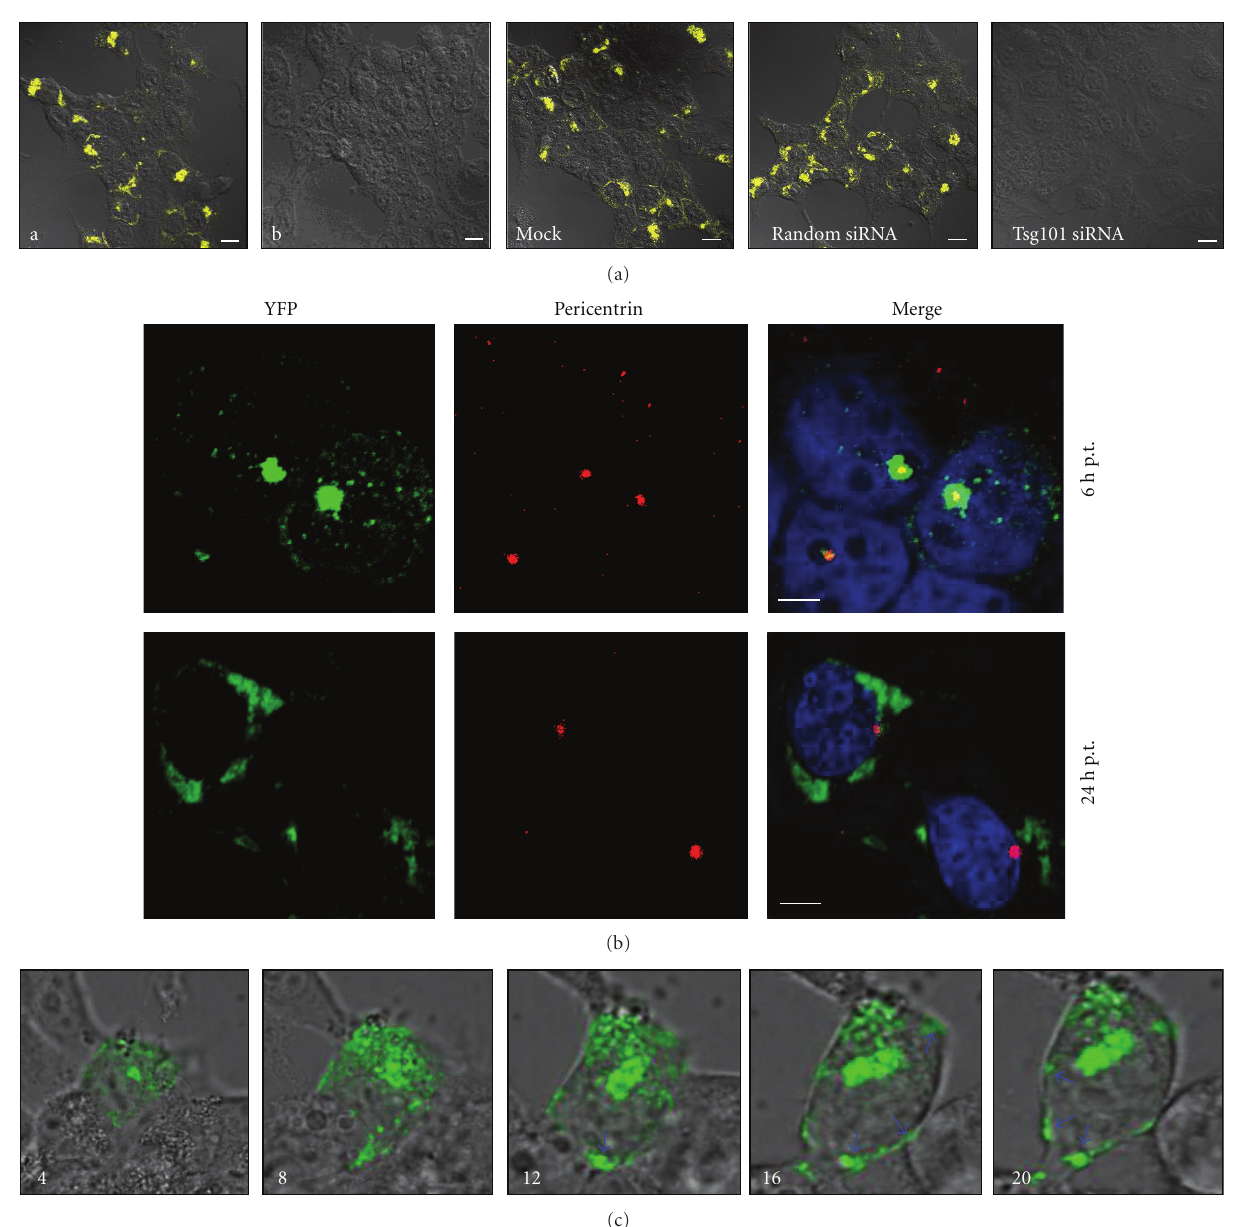
Figure 2: BiMC detecting eVP40-Tsg101 interactions and tra ffi cking of Tsg101/eVP40 complex. (a) Human 293T cells grown on coverslips in 6-well plates were transfected with NYFP-Tsg101 + CYFP-eVP40-WT (a) or NYFP-Tsg101 + CYFP-eVP40- Δ PT/PY. (b) Cells were washed, fixed, and examined for YFP fluorescence by confocal microscopy at 24 hours p.t. Cells were mock-transfected, or transfected with 20nM of Tsg101-specific or random siRNA. Twenty four hours later, cells were mock-transfected or transfected with the same amount of siRNA along with NYFP-Tsg101 + CYFP-eVP40. After an additional 24 hours, cells were examined for YFP fluorescence as described above. (b) Colocalization eVP40-Tsg101 complexes with pericentrin. BiMC assay showing colocalization between pericentrin-B and YFP fluorescence from 293T cells expressing NYFP-Tsg101 + CYFP-eVP40-WT at 6 hours p.t. (top panel) and 24 hours p.t. (bottom panel). (c) DIC images of a single 293T cell co-expressing NYFP-Tsg101 + CYFP-eVP40-WT at 4, 8, 12, 16, and 20 hours p.t. Blue arrows indicate Tsg101/eVP40 complex accumulation at the plasma